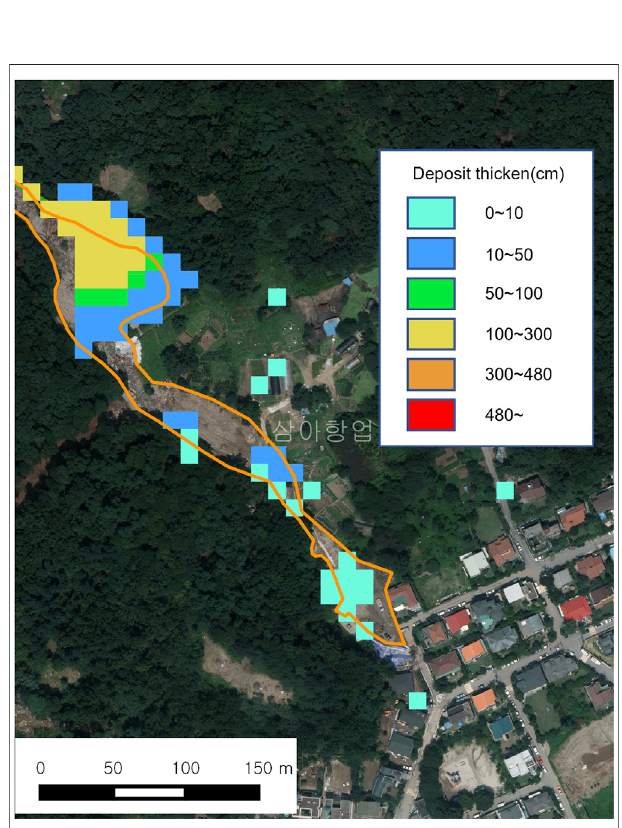
FIGURE 9 | Result of simulated sediment using Hyper Kanako at 1,200 s. Although the simulated deposit fan is discontinuous, the sediment deposition in the reservoir (yellow deposition pixels) was well simulated; the total extent ofdeposition isalso comparable totheactual deposit area in the 2011 event (orange